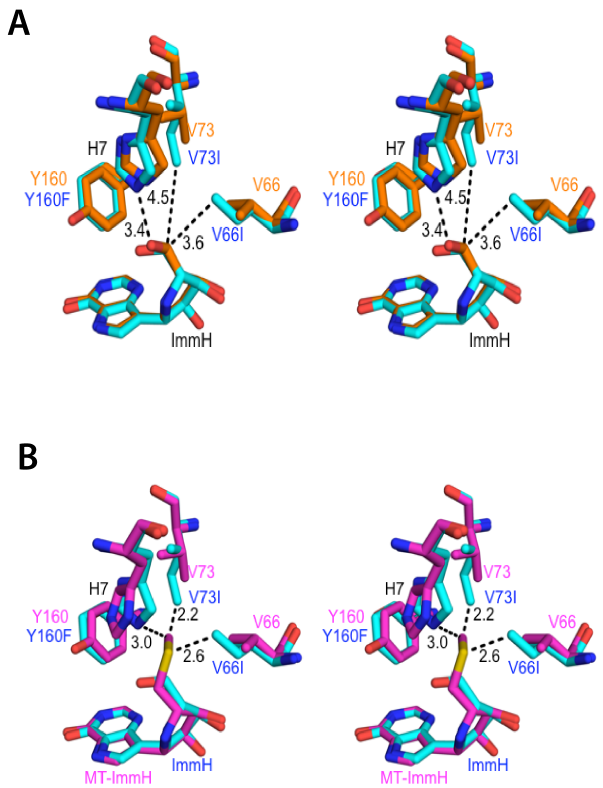
Figure 7. Cross-eyed stereo views of the superposition of Immucillins bound in the catalytic site of V66I:V73I:Y160F PfPNP. A ) V66I:V73I:Y160F PfPNP with ImmH (PDB ID: 3FOW) ( blue ) overlays Wild type PfPNP with ImmH (PDB ID: 1NW4) in orange . B ) An isolated overlay of V66I:V73I:Y160F PfPNP: ImmH (orange) and Wildtype PfPNP: MT-ImmH (1Q1G) ( purple ). The panel shows side chains